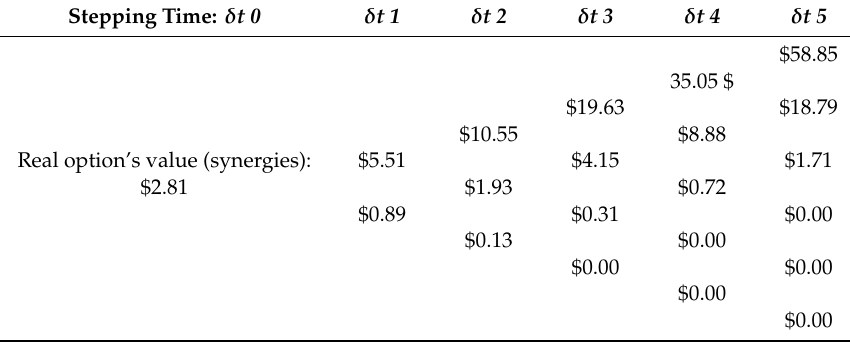
Table 13. Binominal Option pricing model. Real options lattice: a value of synergies of Natura’s acquisition of Avon Products Inc. (in US$